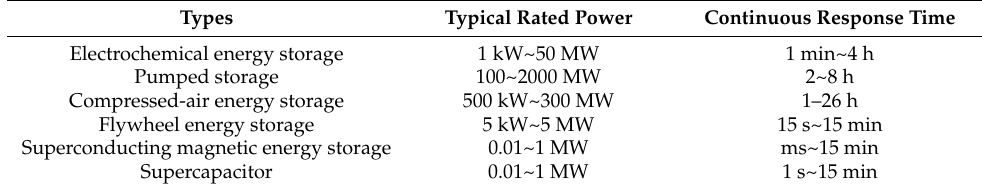
Table 1. Typical rated power and maximum output time of various energy storage systems [8–10].